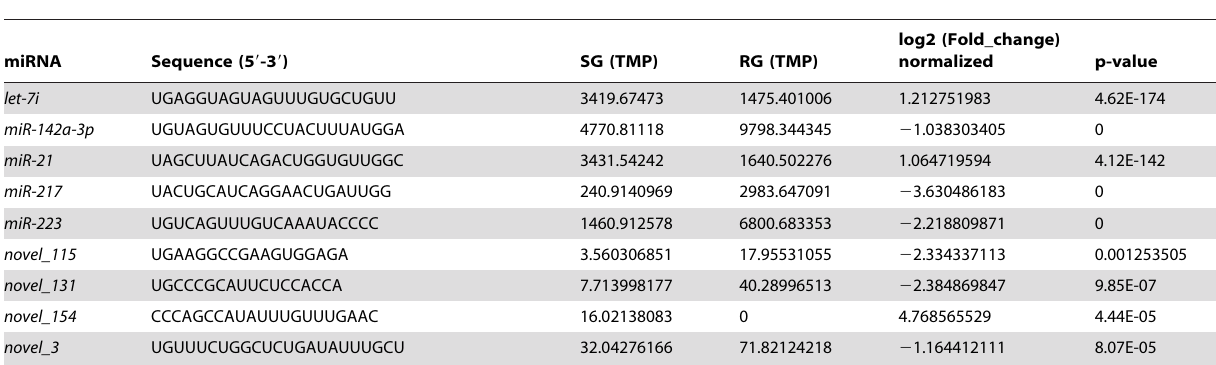
Table 5. Differentially expressed miRNAs in C. idella kidney between SG and RG.